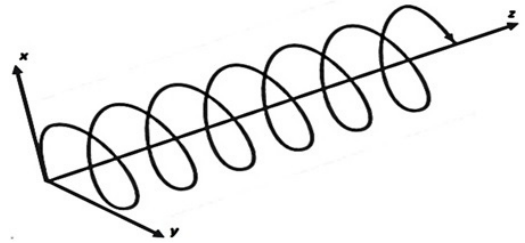
Figure 2. Movement pattern of algal cells.